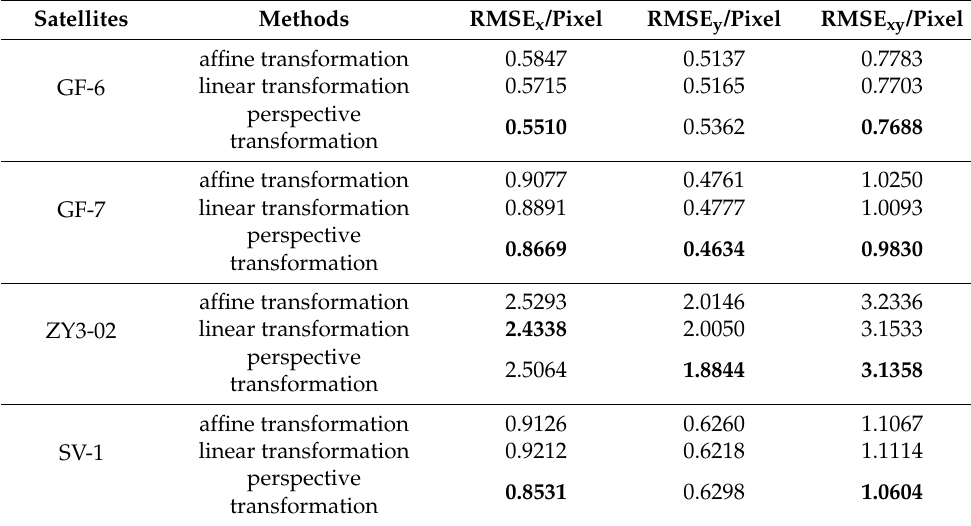
Table 5. The impact of the transformation model for block correction on